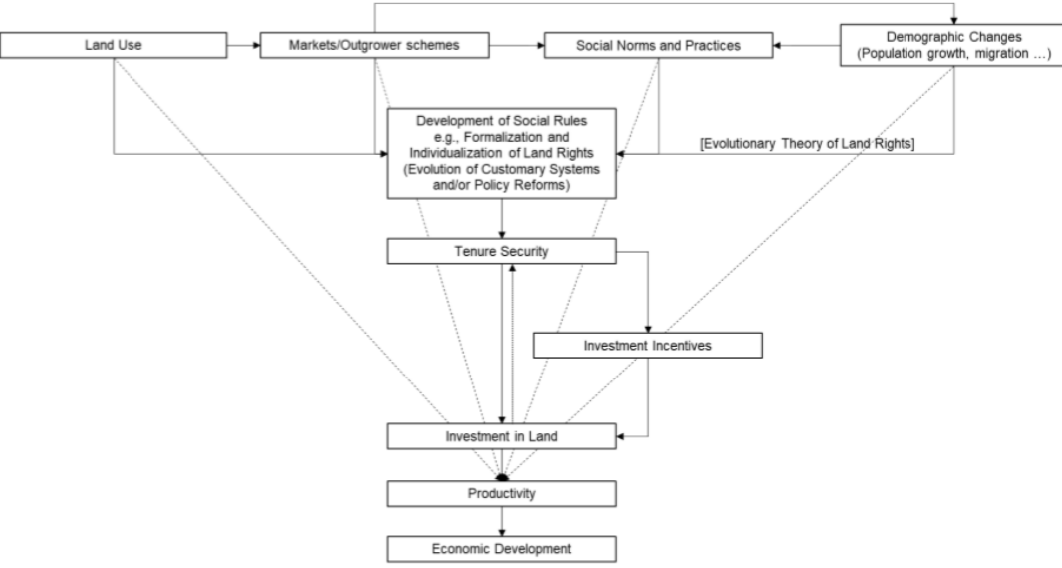
Figure 1. Conceptual framework of tenure security and investments in land in their broader context.